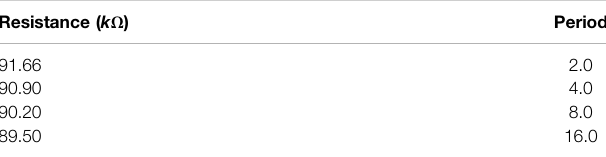
TABLE 1 | Nearby-period-doubling points from Figure 3 showing their respective periods.